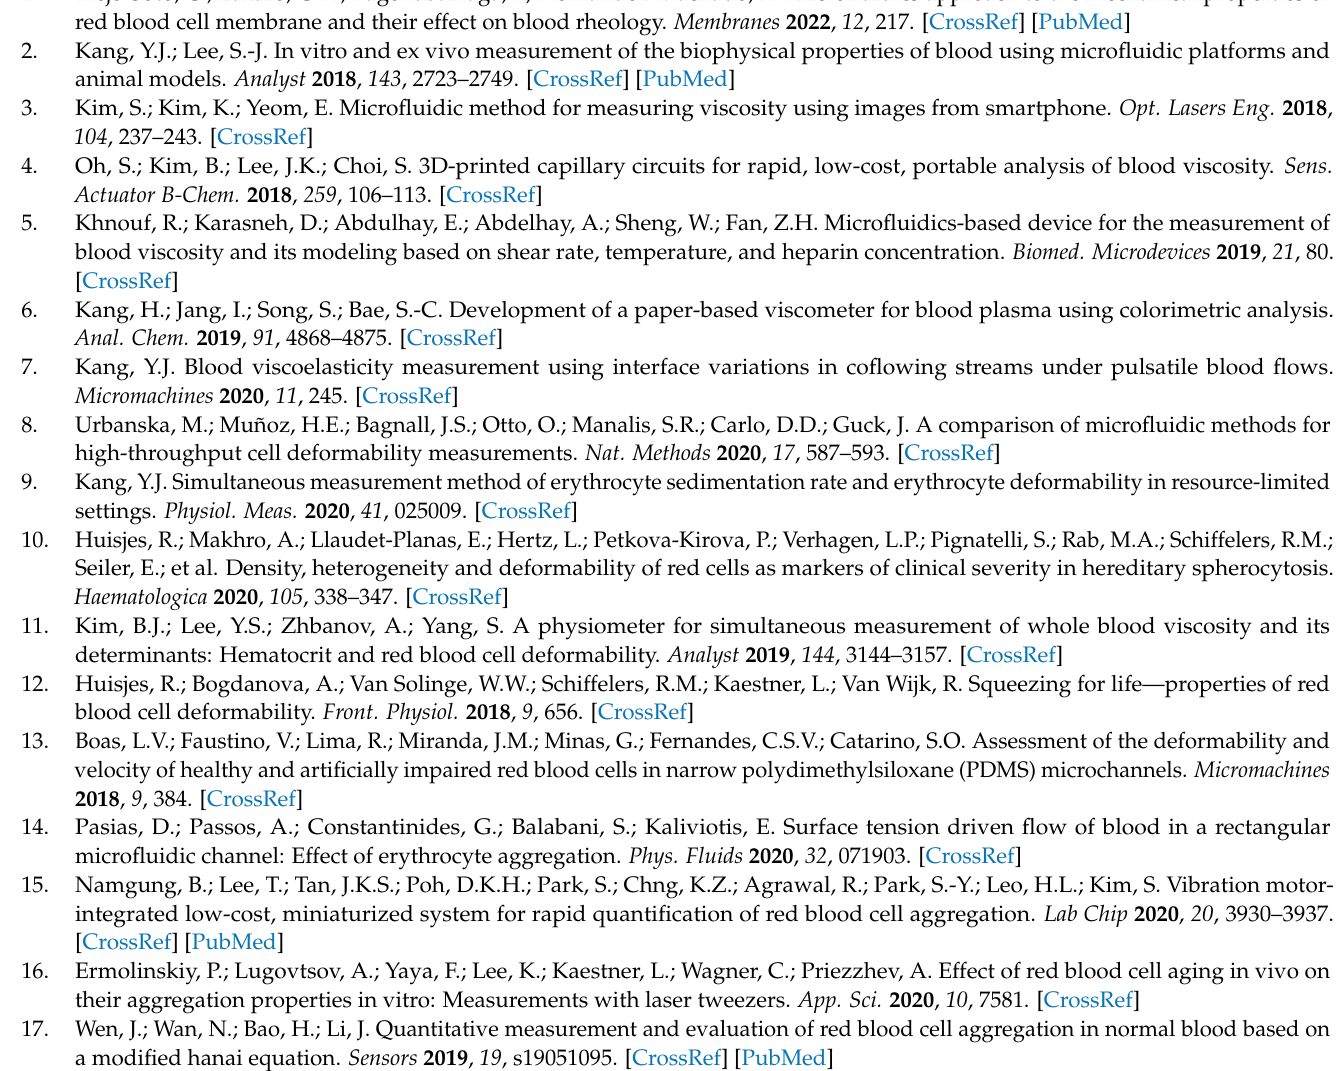
Figure A4. Quantification of RBC aggregation index ( AI ). Based on temporal variations of < I b >, A and B were calculated for ∆ t = t 2 − t 1 ; the AI was then obtained as AI = A/(A + B).